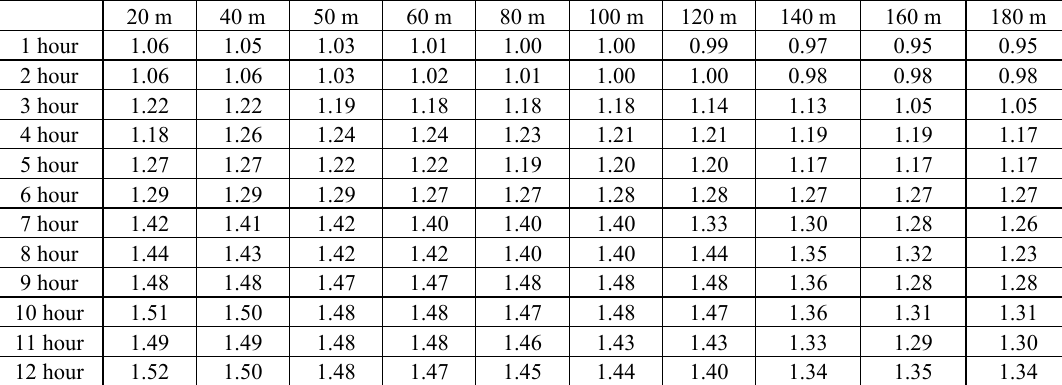
Table 2. Root mean squared error (RMSE) at different heights and different prediction